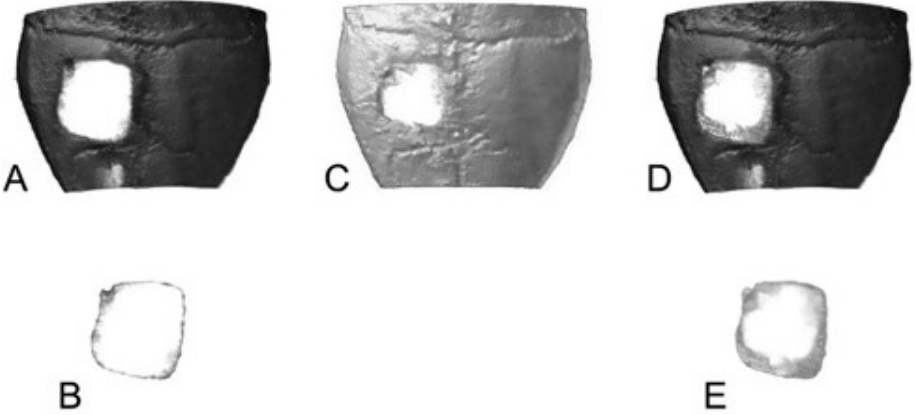
Figure 3. µCT scans of the skull. Dorsal view at the calvaria of a mouse from control group 1 at day 0 ( A ) and the (cut out ROI ( B ); Same view at day 28 without ( C ) and with overlaid first scan ( D ) resulting in the ROI for day 28 ( E )).